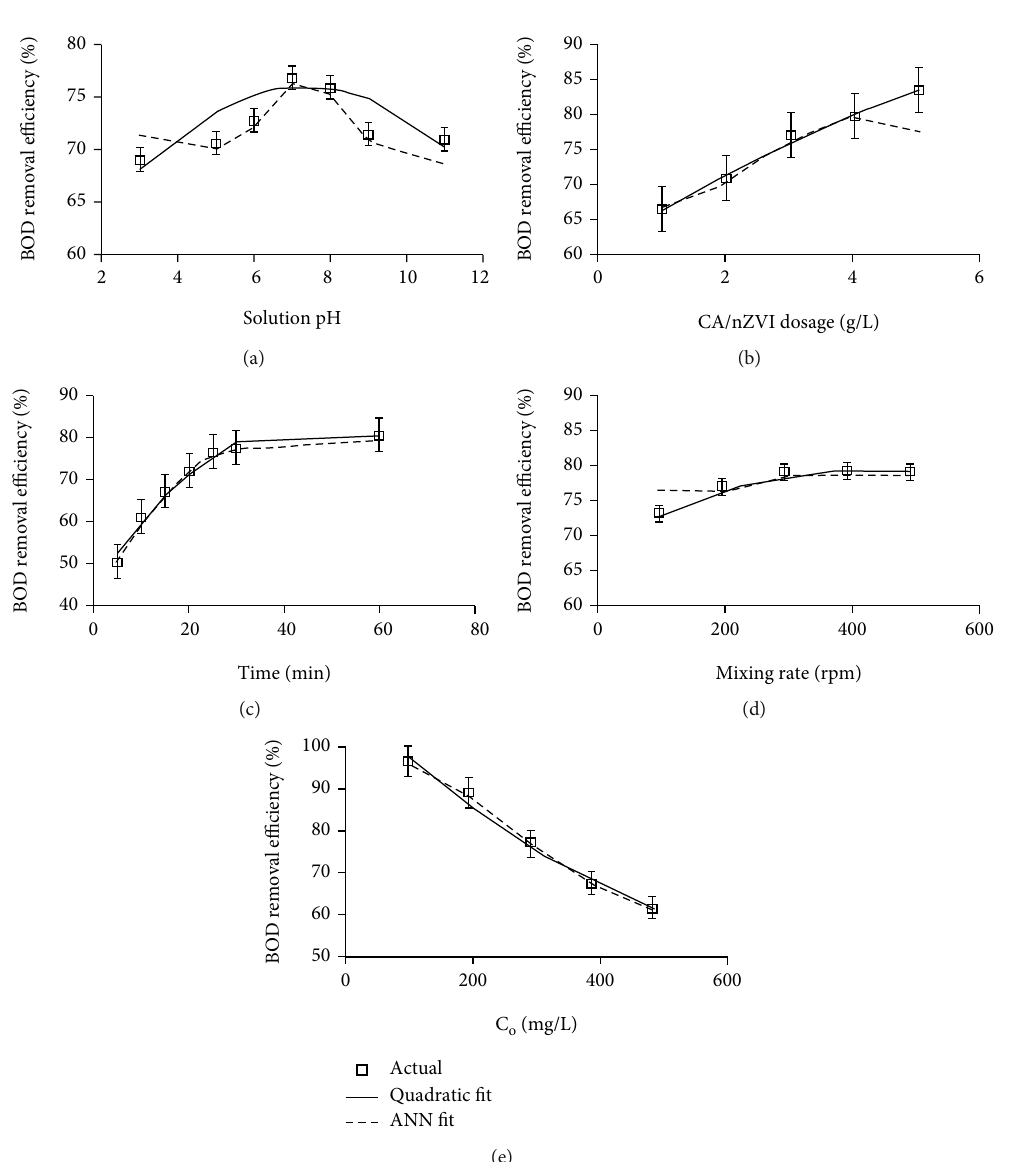
Figure 3: In fl uences of adsorption factors on BOD removal e ffi ciency: (a) solution pH, (b) adsorbent dosage, (c) contact time, (d) stirring rate, and (e) initial adsorbate